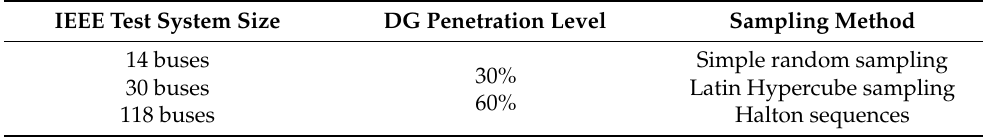
Table 4. Review of simulation